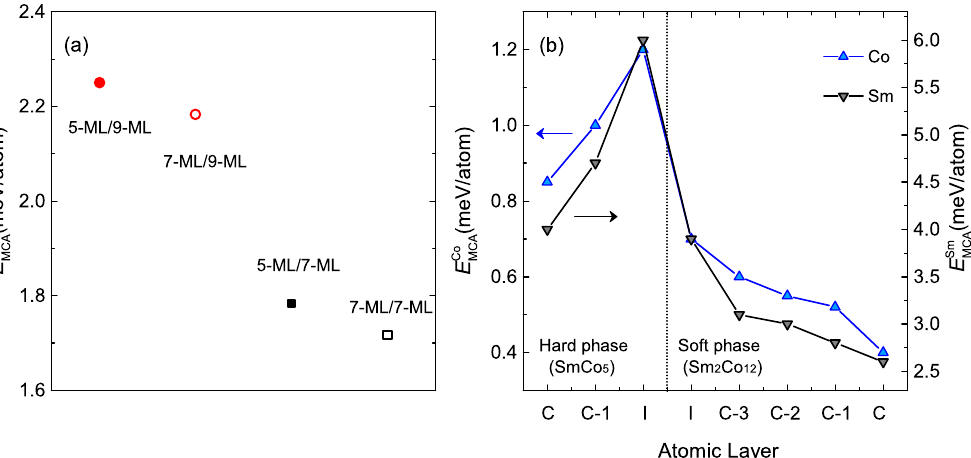
Figure 4. ( a ) Magnetocrystalline anisotropy energy ( E MCA ); ( b ) Partial E MCA of Co and Sm with respect to the atomic layer of 5-ML/9-ML